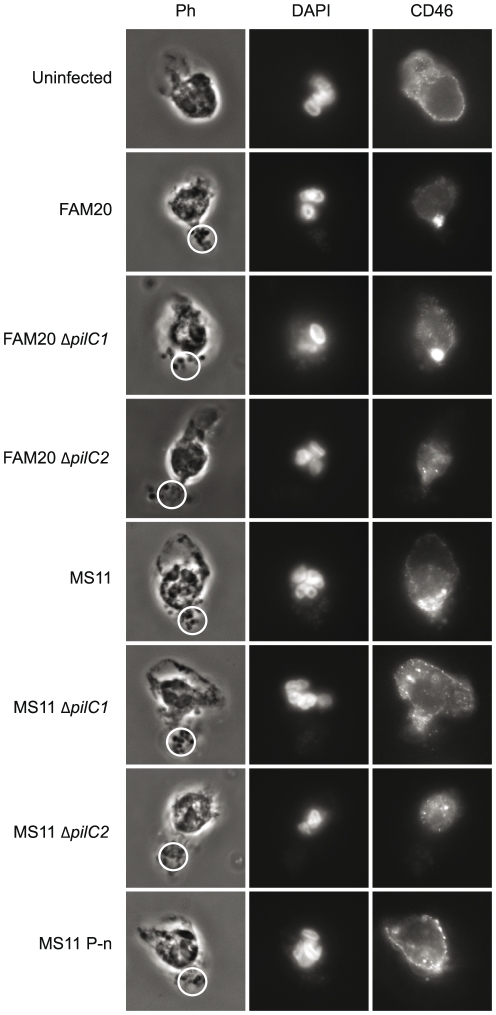
CD46 accumulates at the uropod adjacent to adhering bacteria.
N. gonorrhoeae MS11 and N. meningitidis FAM20 bacteria were allowed to adhere to freshly isolated PMNs. Cells were fixed, permeabilized and incubated with polyclonal antibodies against CD46 and cellular DNA was stained with DAPI. Phase contrast images show the PMN morphology and bacterial adherence. Circles indicate bacteria. Representative images of CD46 expression in PMNs infected with wild-type and mutant gonococci and meningococci are shown.